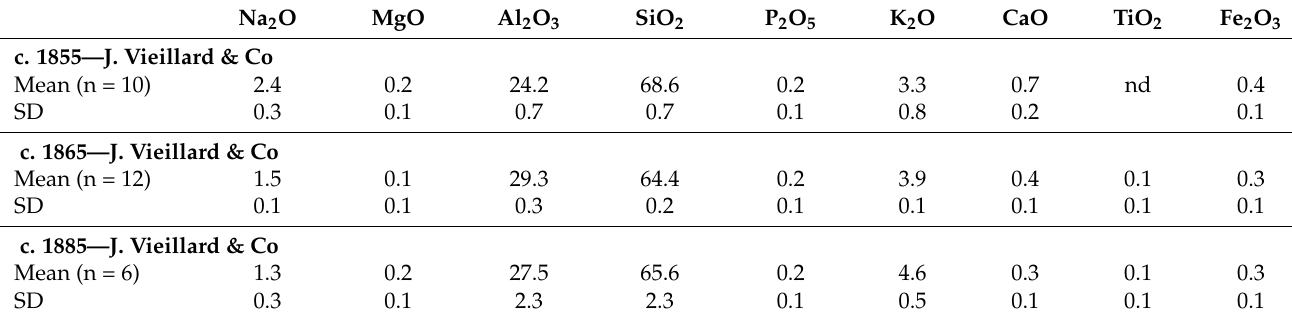
Table 3. Average chemical composition and standard deviation of the ceramic’s body, measured by EDS analysis (wt% normalized to 100%). The data are the average over at least two analyses taken in different areas of the ceramic bodies. SD = standard deviation; nd = non